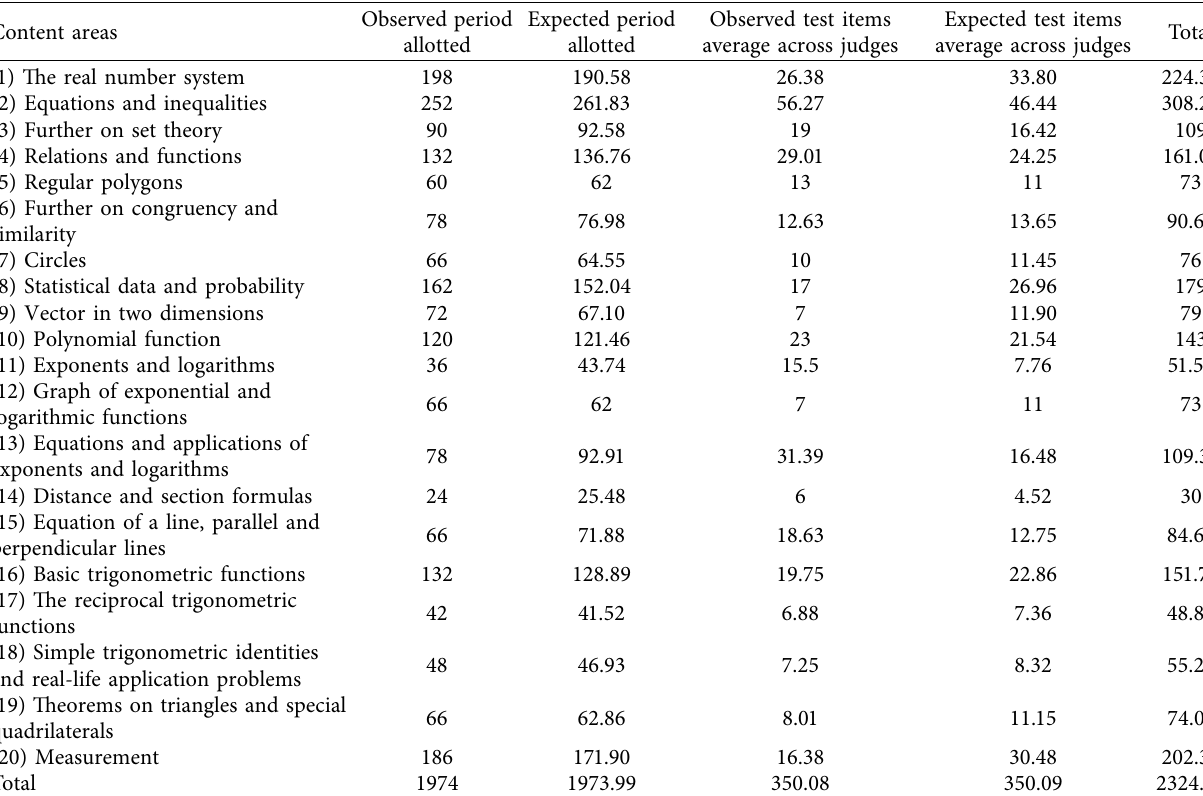
Table 7: The number of observed and expected tests items that determined from the contents of the syllabus by judges. Content